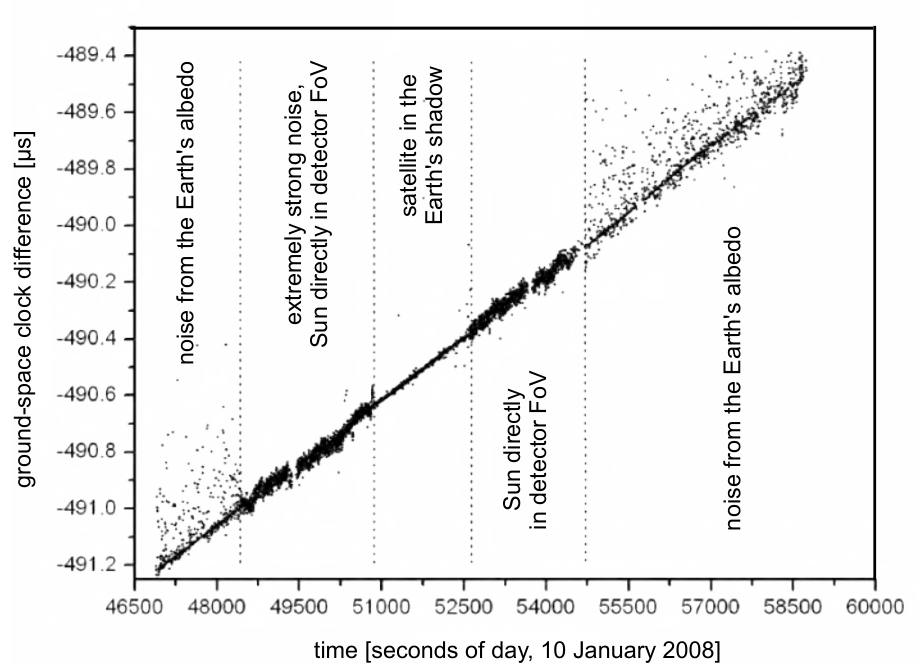
Figure 17. Comparison of ground hydrogen maser and on-board rubidium clock via optical time transfer in frame of LTT project. Several conditions are depicted [32]. This is typical configuration for M1 satellite, for other satellites the field of view has been modified to eliminate direct Sun